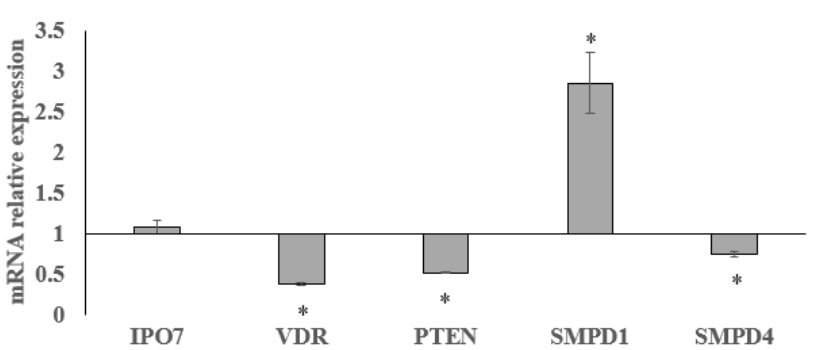
Figure 3. Effect of gentamicin on Ipo7, VDR, PTEN, SMPD1, SMPD4 , gene expression. GAPDH expression was used as a housekeeping gene. RT-PCR analysis was performed in control and experimental NCI-N87 cells collected 24 h after 1.5 mM GM treatment. Data are expressed as the mean ± SD of three independent experiments performed in three PCR replicates (significance, * p < 0.001 versus control sample).